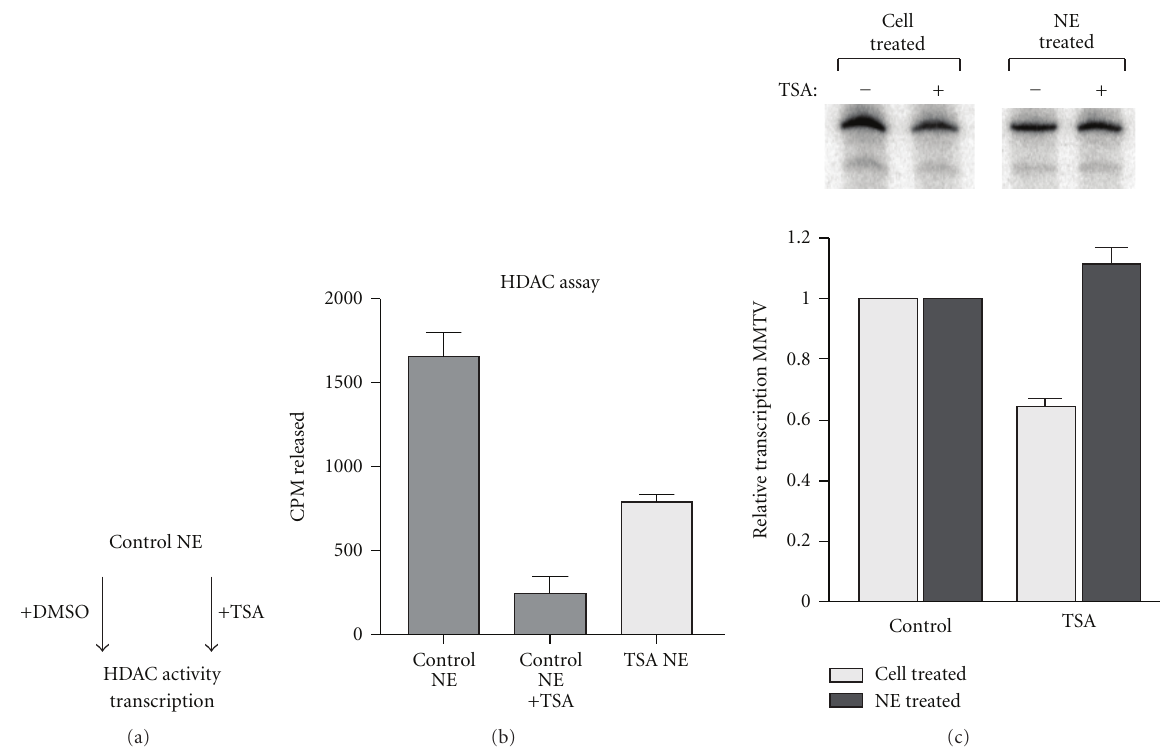
Figure 7: HDAC activity is not required during transcription of the MMTV promoter. (a) shows the experimental outline. Vehicle (DMSO) or TSA (50ng/ml) was added to extracts from untreated (control) cells. These extracts were then subjected to HDAC assay or used for in vitro transcription. (b) shows the results of HDAC assays on control extracts to which vehicle or TSA had been added. The same assay was performed on extracts from cells treated with TSA as a comparison. The graph represents data from 3 independent experiments. (c) shows the results of in vitro transcription from the MMTV template comparing extracts from cells treated with or without TSA (Cell treated) with extracts from untreated (control) cells to which vehicle or TSA had been added (NE treated). The graph was generated from data derived from at least 3 independent experiments. Error bars represent